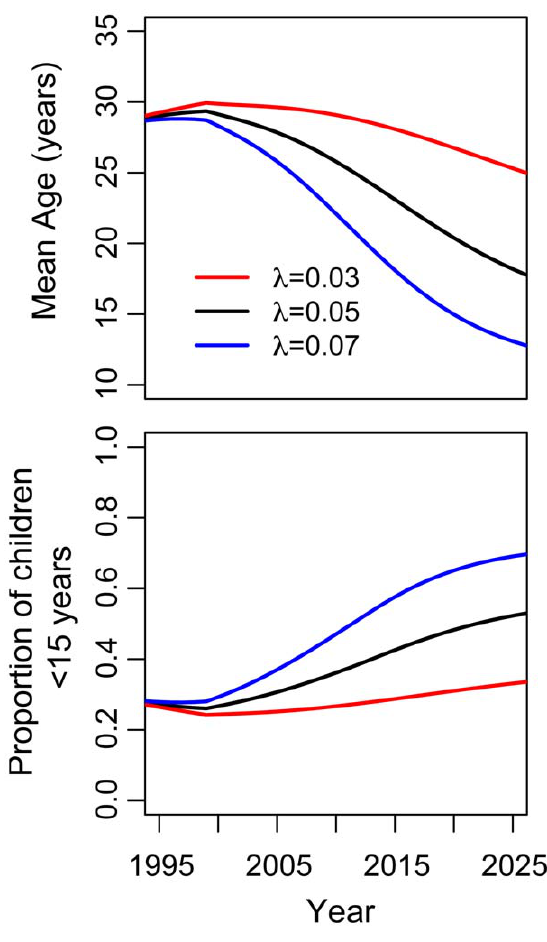
Figure 5. Predicted changes in the age distribution of monotypically immune (DHF/DSS) over time. Estimated mean age of monotypically immune (top) and proportion of monotypically immune (DHF/DSS cases) that are children under 15 years (bottom) at several time points after the introduction of DENV into a previously susceptible